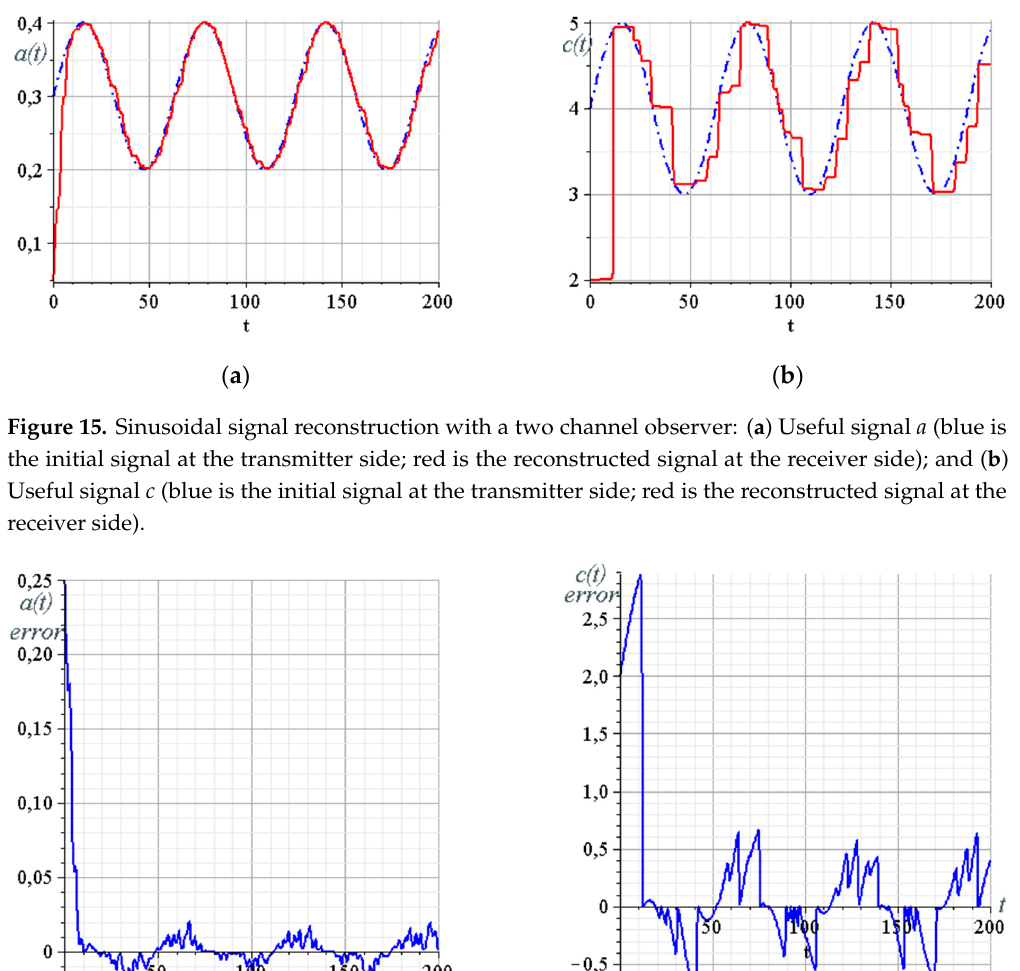
Figure 15. Sinusoidal signal reconstruction with a two channel observer: ( a ) Useful signal a (blue is the initial signal at the transmitter side; red is the reconstructed signal at the receiver side); and ( b ) Useful signal c (blue is the initial signal at the transmitter side; red is the reconstructed signal at the receiver side). Figure 16. Sinusoidal signal reconstruction error: ( a ) Signal a reconstruction error; and ( b ) Signal c reconstruction error.